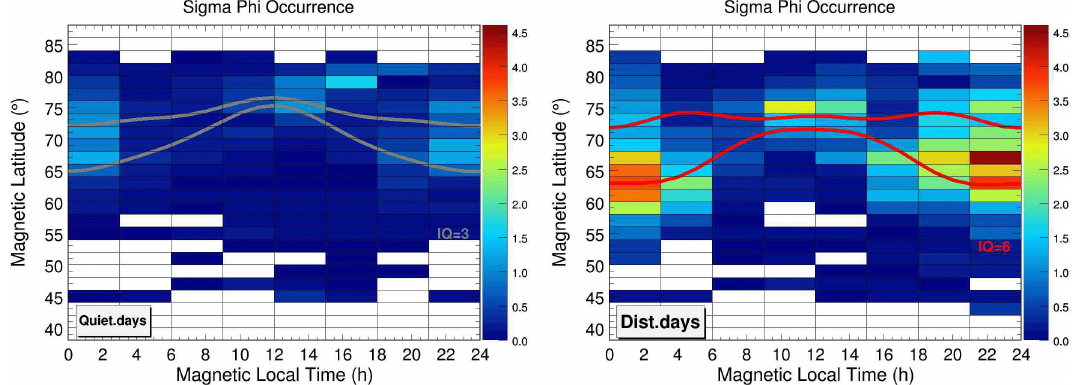
Fig. 5. Maps of σ φ percentage of occurrence merging data from all stations: left is for the quiet days with the IQ=3 oval in grey, while right is for disturbed days with the IQ=6 oval in